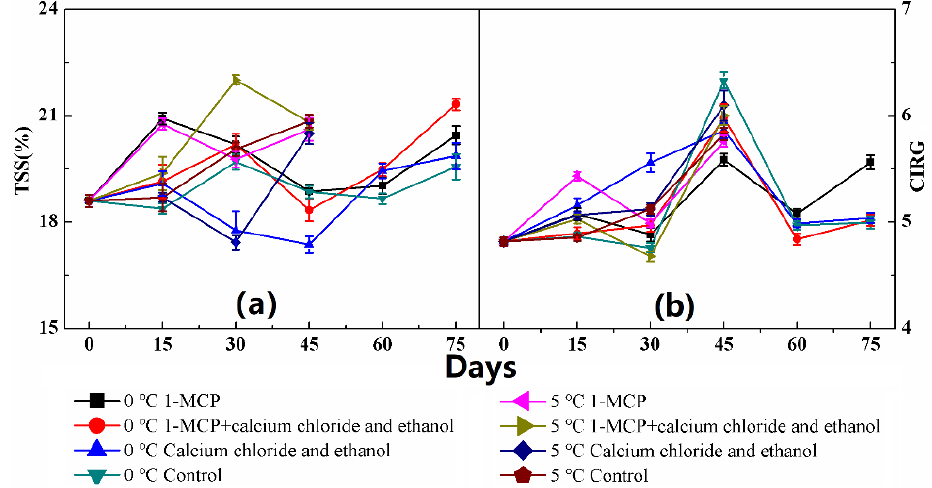
Figure 2. Dynamic changes of TSS ( a ) and CIRG ( b ) value of grape berry. The data is presented as mean ± standard error (SE) of at least three repetitions.